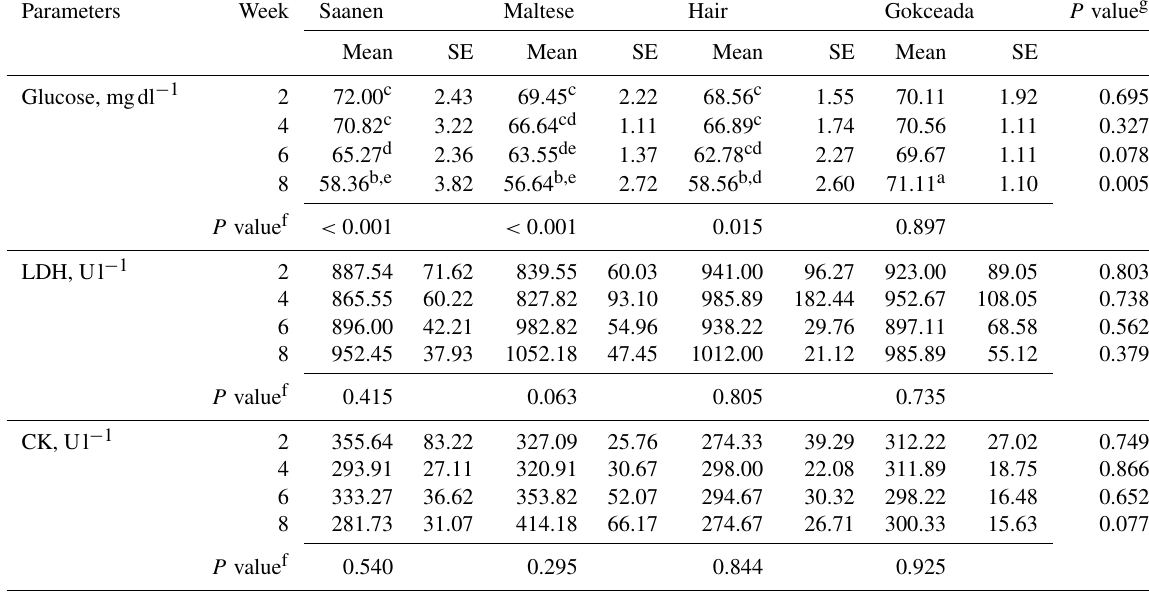
Table 2. Plasma glucose, lactate dehydrogenase (LDH) and creatine kinase (CK) levels in different periods of fattening due to breed.